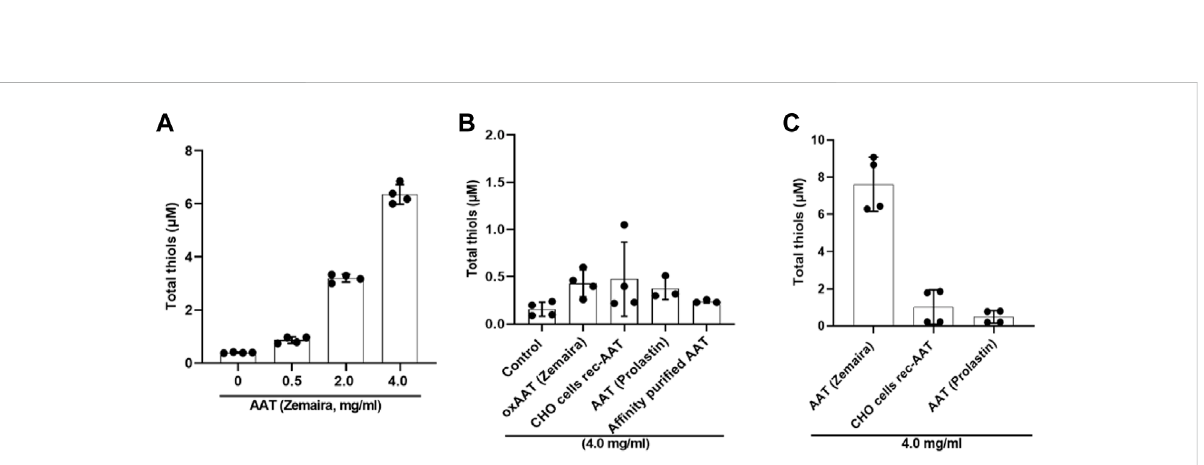
FIGURE 5 Supernatants from PBMCs pre-treated with various AAT preparations differ in their total thiol levels. Total thiol assay was performed using fi lteredsupernatants(through3 kDacentrifugal fi lters)fromtotalPBMCspre-incubatedfor30 minwithvariousconcentrationsupto4 mg/mlofAAT (A) (Zemaira ® ) or (B) with a constant concentration of 4 mg/ml of various AAT preparations, including, oxAAT (Zemaira ® ), and (C) with a constant concentration of 4 mg/ml AAT proteins alone prepared in PBS. Each bar represents mean (SD) from two independent experiments with